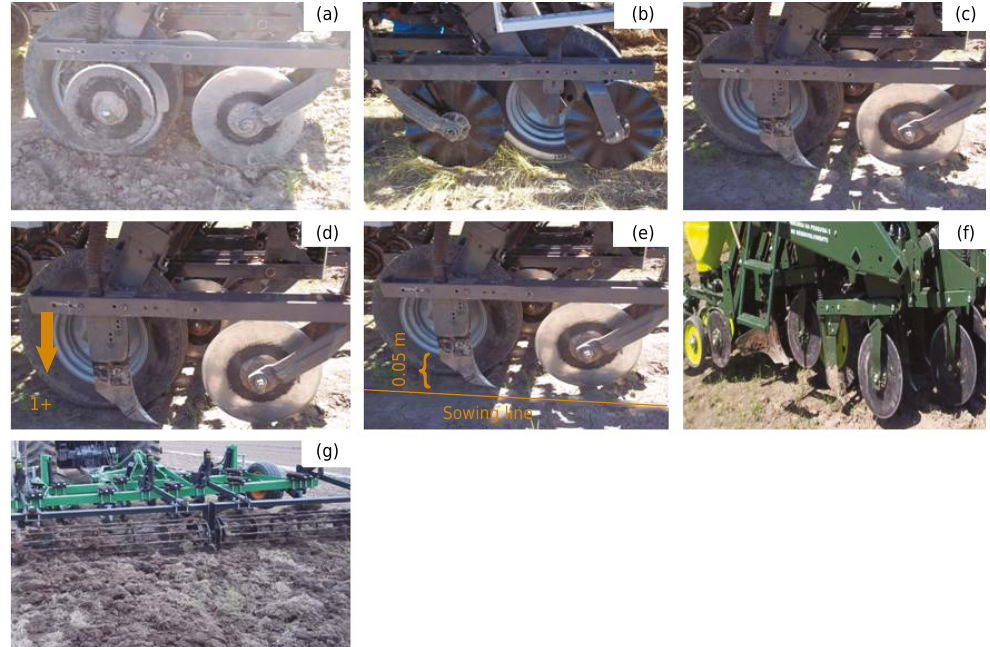
Figure 1. Tillage systems used for soybean: sowing with offset double disc (a); sowing with a fluted coulter disc (b); sowing with a knife runner opener (c); sowing with a knife runner opener + press wheel mechanism for ground levelling (1) (d); sowing with knife 0.05 m from the planting row (e); raised bed system (f); and chisel plough + sowing using an offset double disc (g). Arrow indicates position in which the soil press wheel mechanism for ground levelling was